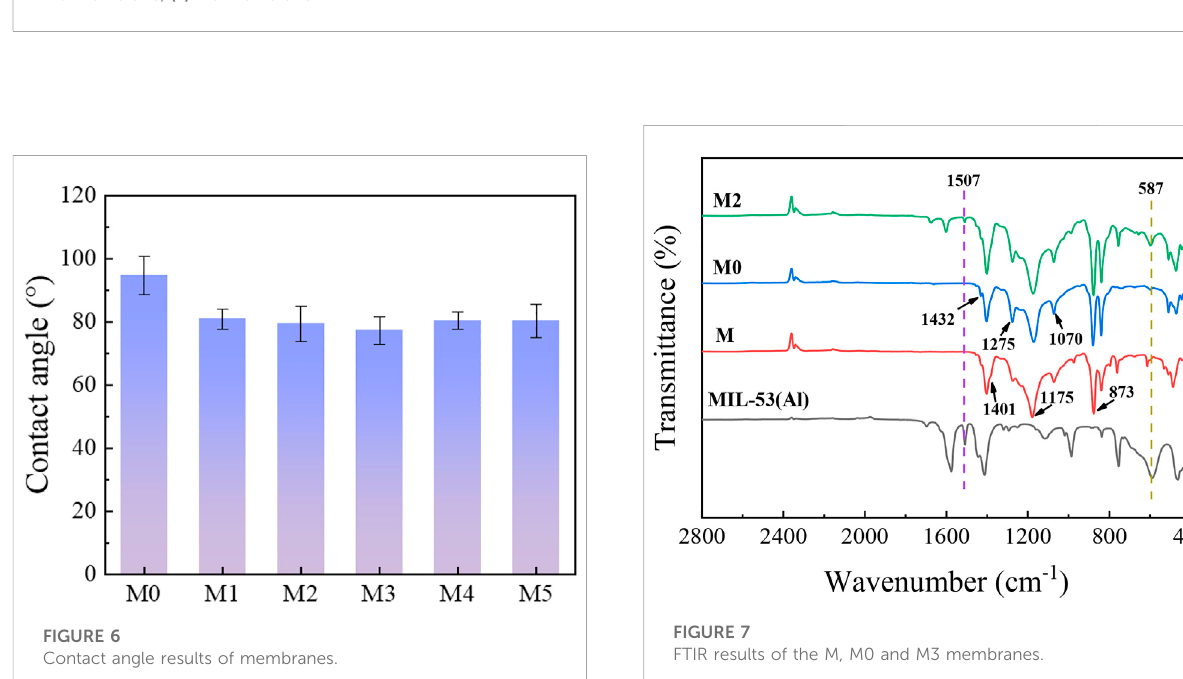
FIGURE 7 FTIR results of the M, M0 and M3